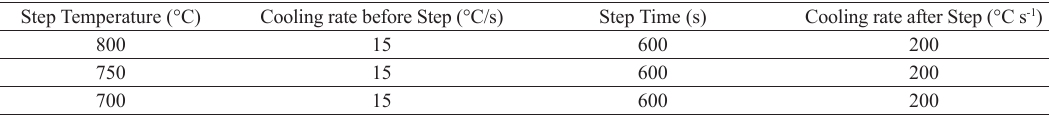
Table 2. SQ heat treatment routes employed to evaluate the step temperature effect on ferrite fraction on the quasi-equilibrium condition.